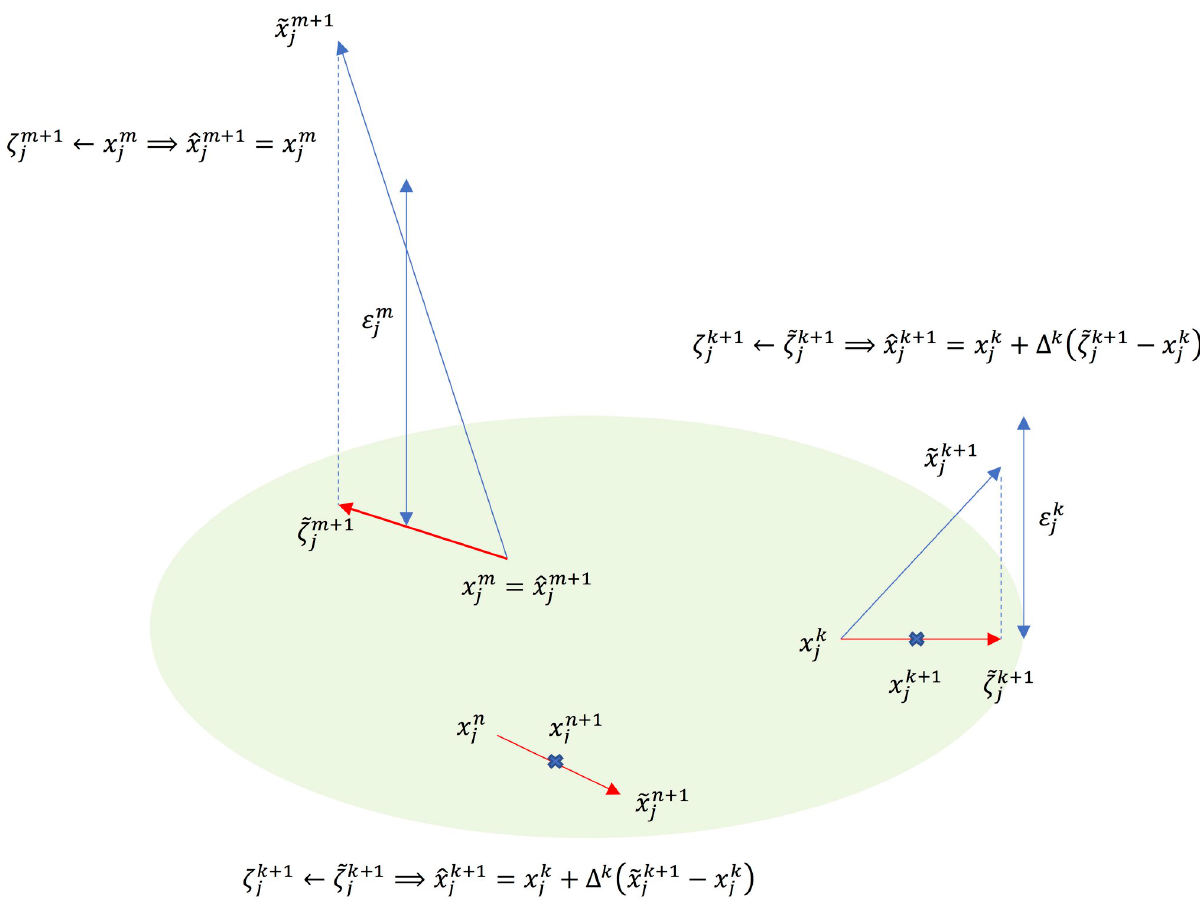
, 2) an infeasible solution, but the distance between the solution j (cid:0) ~ x k þ 1 k � ε k , and 3) an infeasible solution in that the projection onto the feasible j j j